Question: In one sentence, what is this figure communicating?
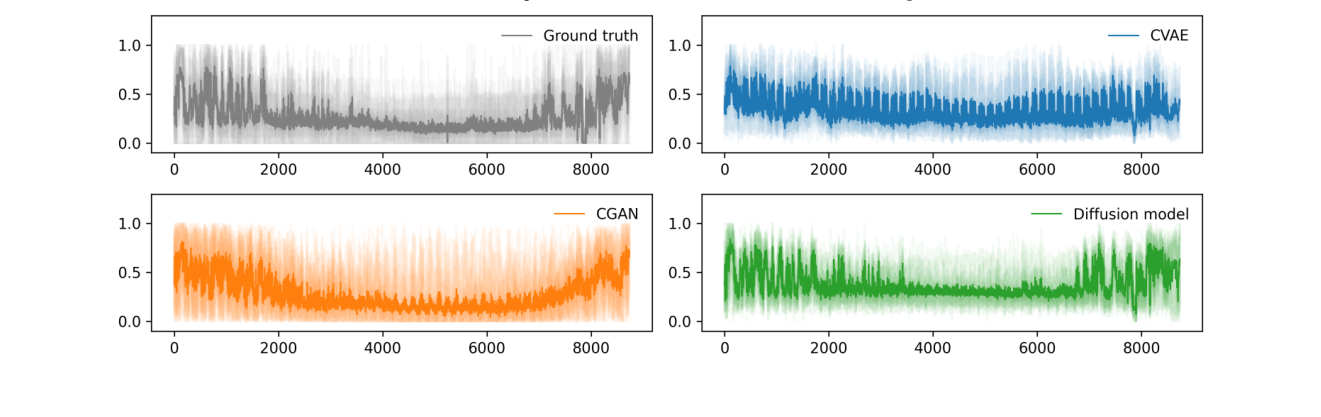
Answer: Comparison of ground truth and generated time series across models for different meter and building types with added transparency (hourly data visualized over a year).